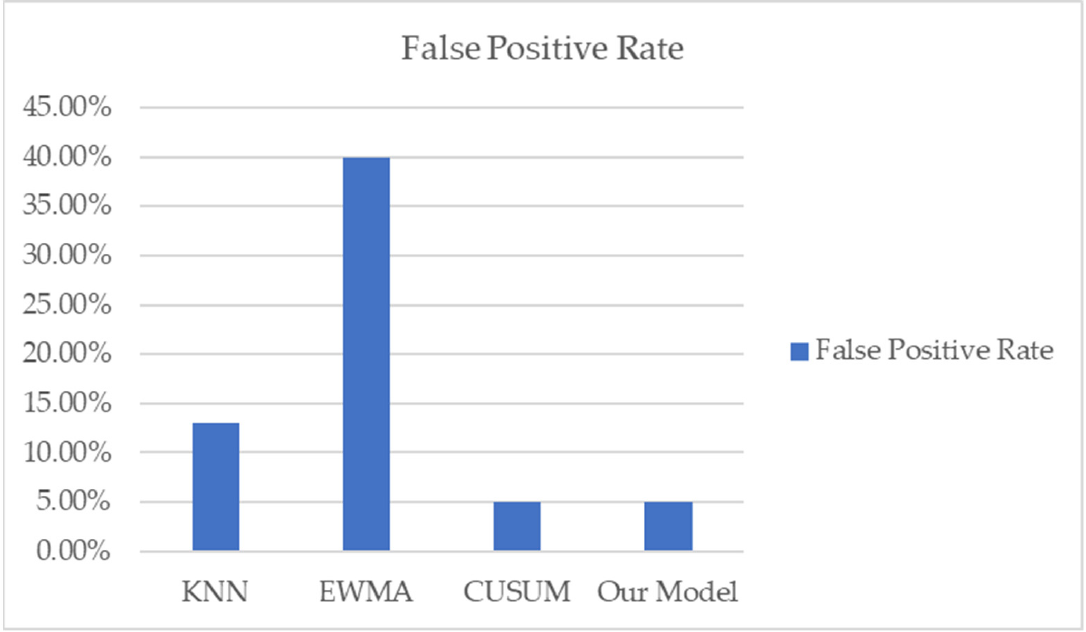
Figure A9. Comparison of the FPR of EWMA, CUSUM, and KNN with our model.